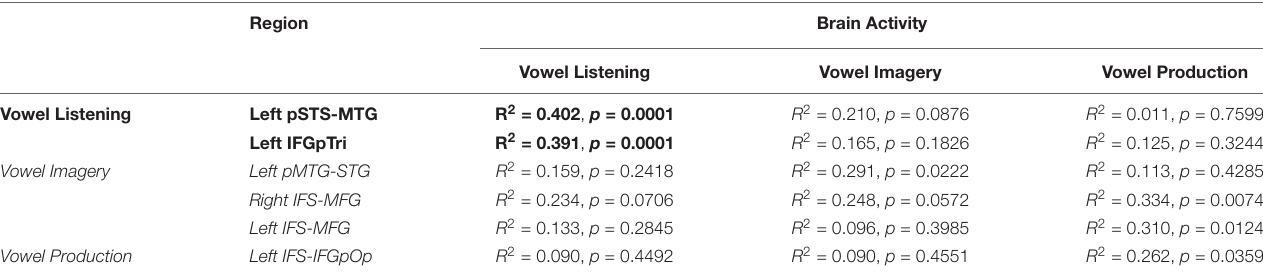
TABLE 2 | CCA results in regions from vowel listening, imagery and perception (lines), between brain activity in each task (columns) and the formant model.